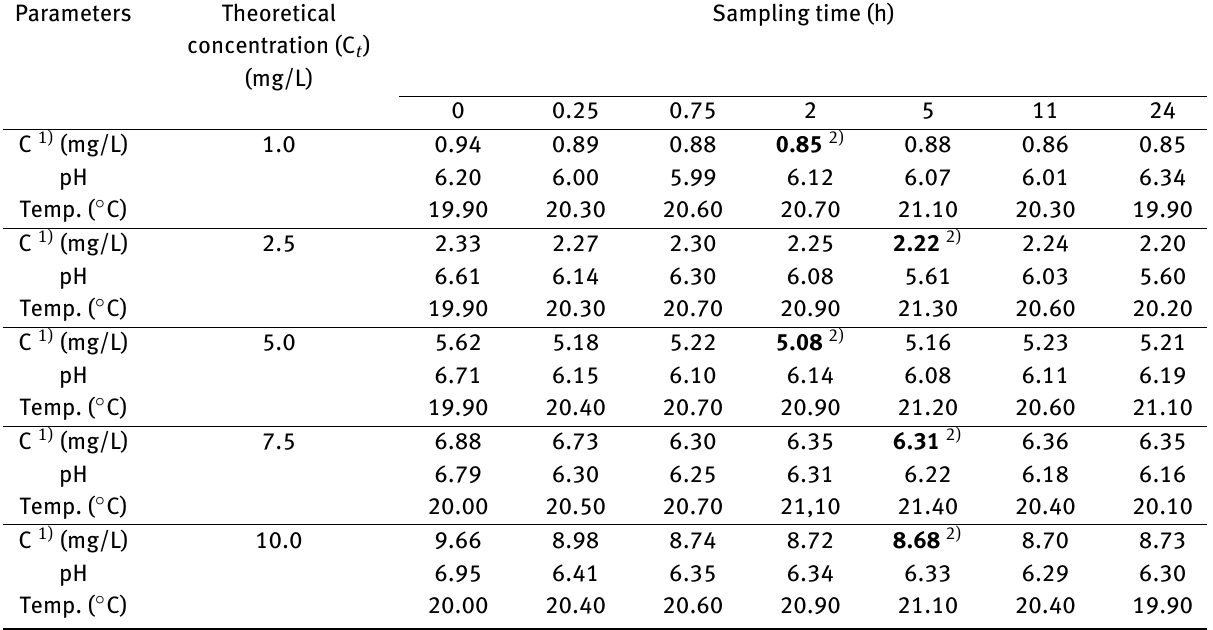
Table 1: Results for experiments with Cr Parameters